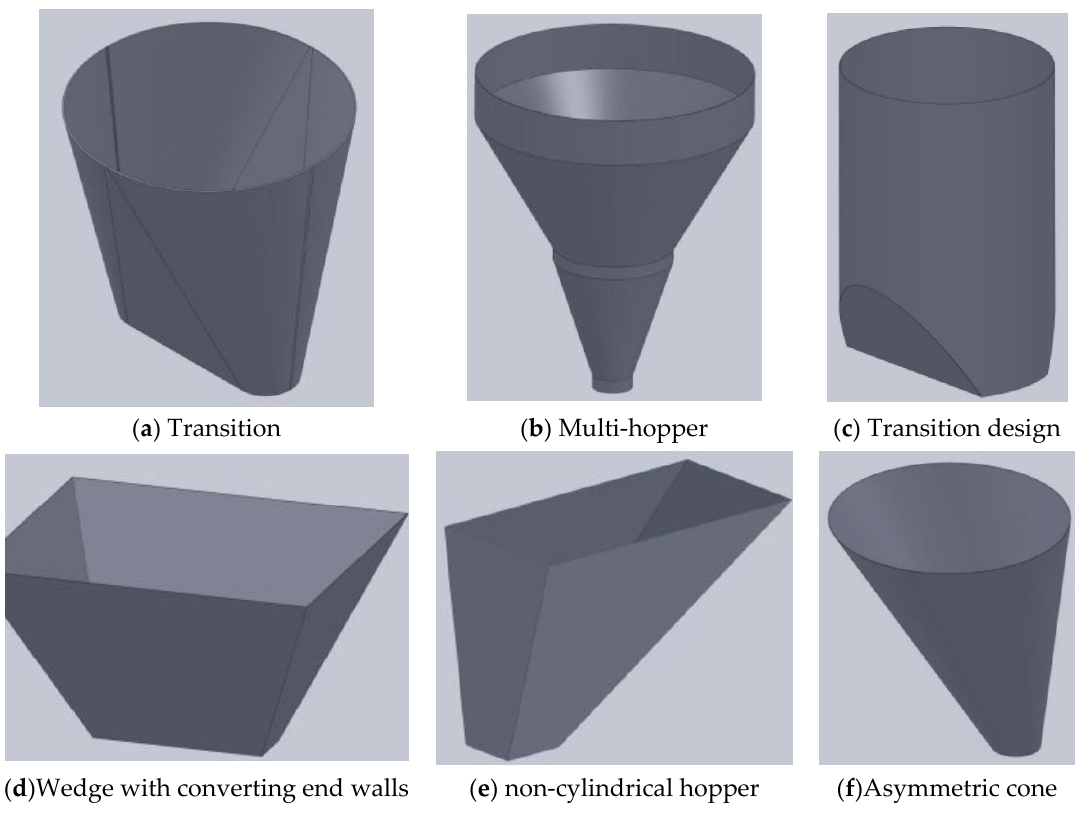
Figure 3. ( a – f ) Standard silo hopper designs [1].